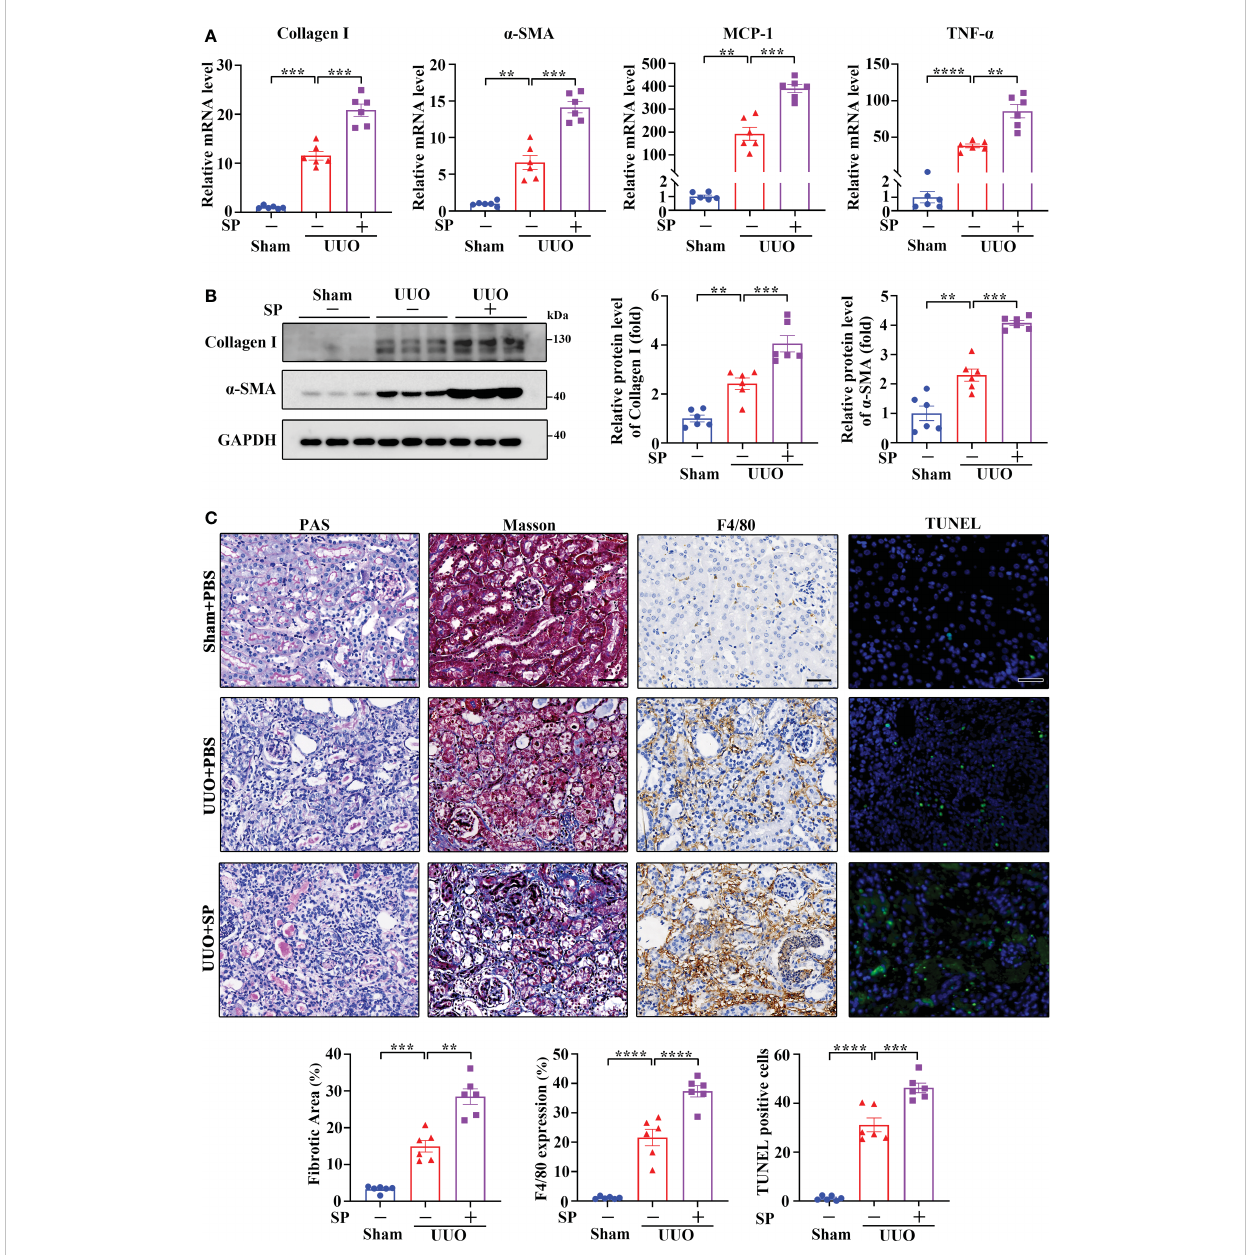
FIGURE 4 Administration of SP exacerbated UUO-induced renal fi brosis, in fl ammation, and apoptosis. (A – C) RT-qPCR (A) , Western blotting (B) , PAS, Masson ’ s trichrome, F4/80 immunochemistry staining, and TUNEL analysis (C) . Results showed that SP administration in established UUO mice enhanced the expression of Collagen I, a -SMA, MCP-1, and TNF- a at mRNA and/or protein levels, which was accompanied by aggravated renal fi brosis, in fi ltration of F4/80-positive in fl ammatory cells, and apoptosis. For (A – C) , sham and UUO mice were subjected to vehicle (PBS) or SP (40 nM/kg body weight) by tail vein injection three times a week for 14 days. The quantitative analysis of TUNEL-positive cells was achieved by fl uorescence microscopy in 10 randomly chosen high-power fi elds per kidney section. Scale bar, 50 µm. Data are shown as mean ± SEM from groups of six mice. ** p < 0.01; *** p < 0.001; **** p <